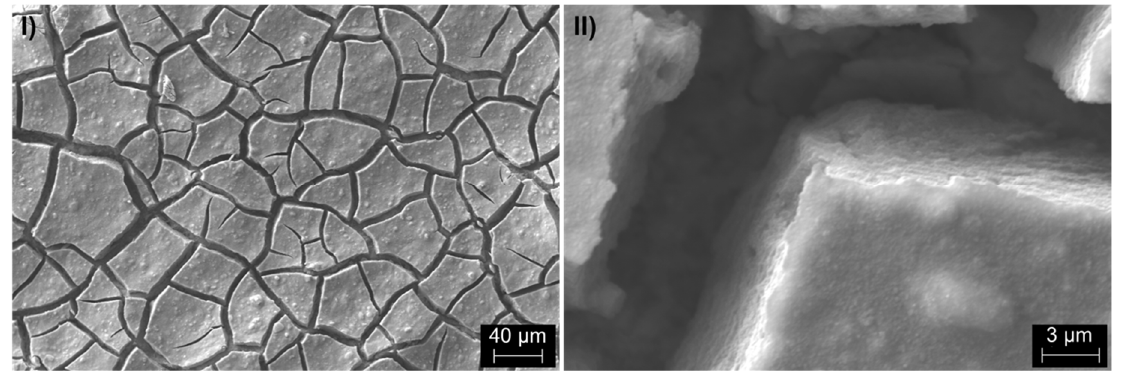
Figure 6. Environmental scanning electron microscopy images of P25 immobilized by spray coating on a rough steel substrate; U = 15 kV, I = 1.4 nA, high vacuum, 250 ‐ fold magnification ( I ) and 4 k ‐ fold magnification ( II ).